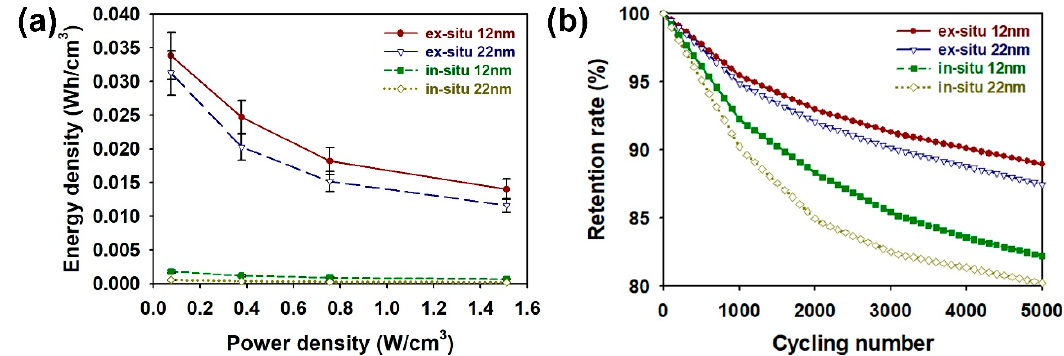
Figure 7. ( a ) Ragone plots and ( b ) cycling stability of coin cells containing core-shell NPs prepared by different synthetic conditions.